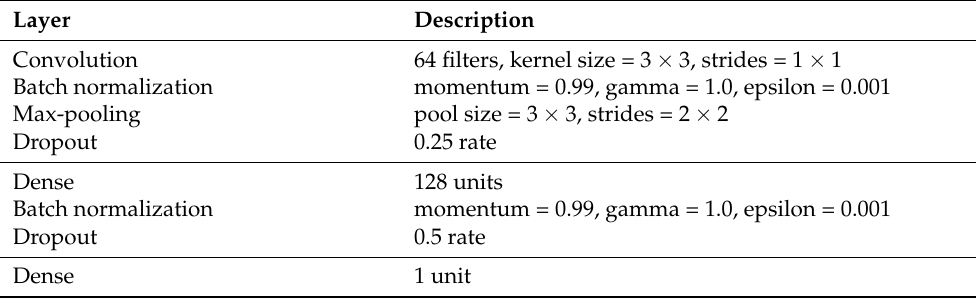
Table 1. Cont. Layer